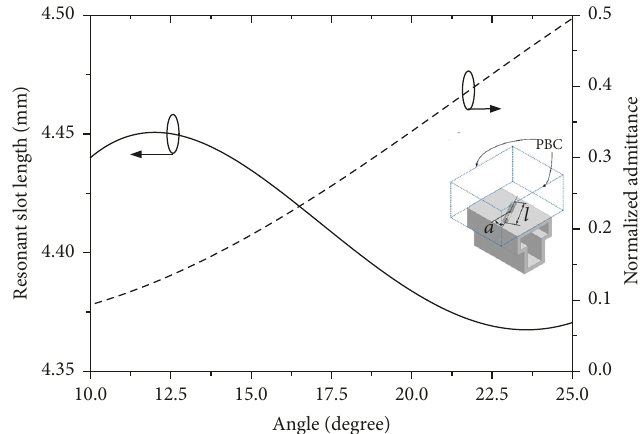
Figure 3: Normalized admittance and resonant length regarding the inclined